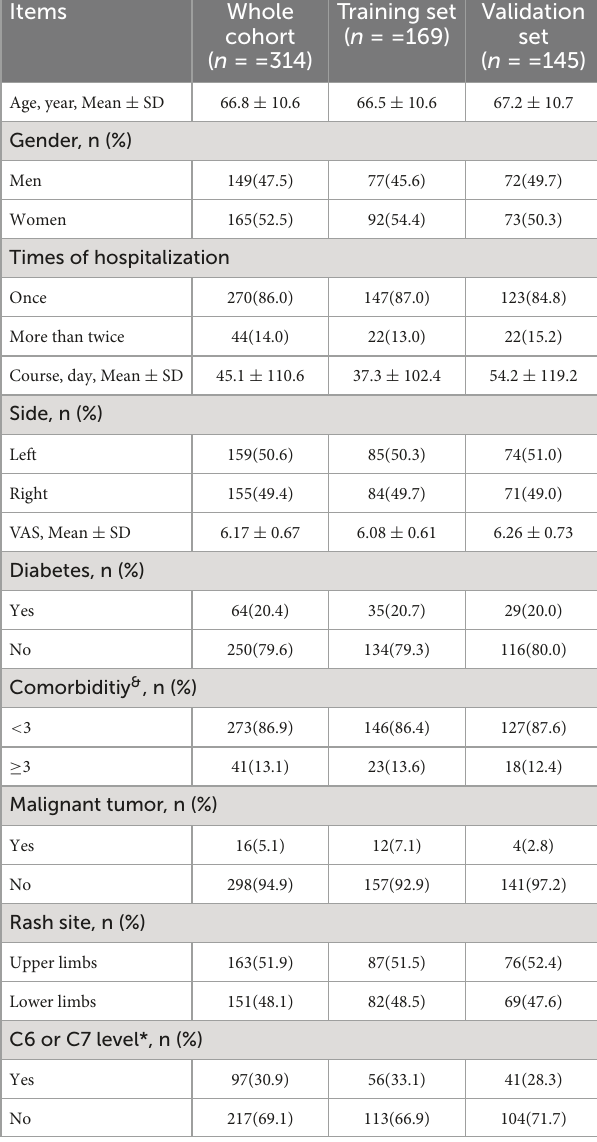
TABLE 1 Baseline characteristics of participants in the training set and validation